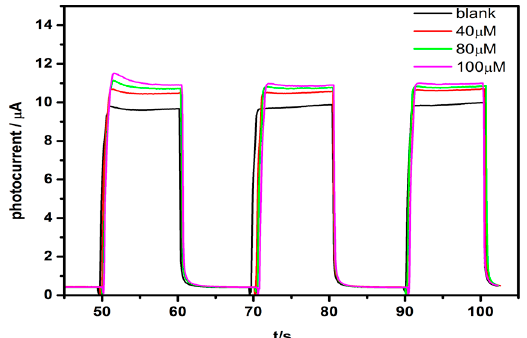
Figure 4. The photocurrent responses of the AuNPs/AChE/TiO 2 NTs modified electrode in different concentration of ATCl solutions.